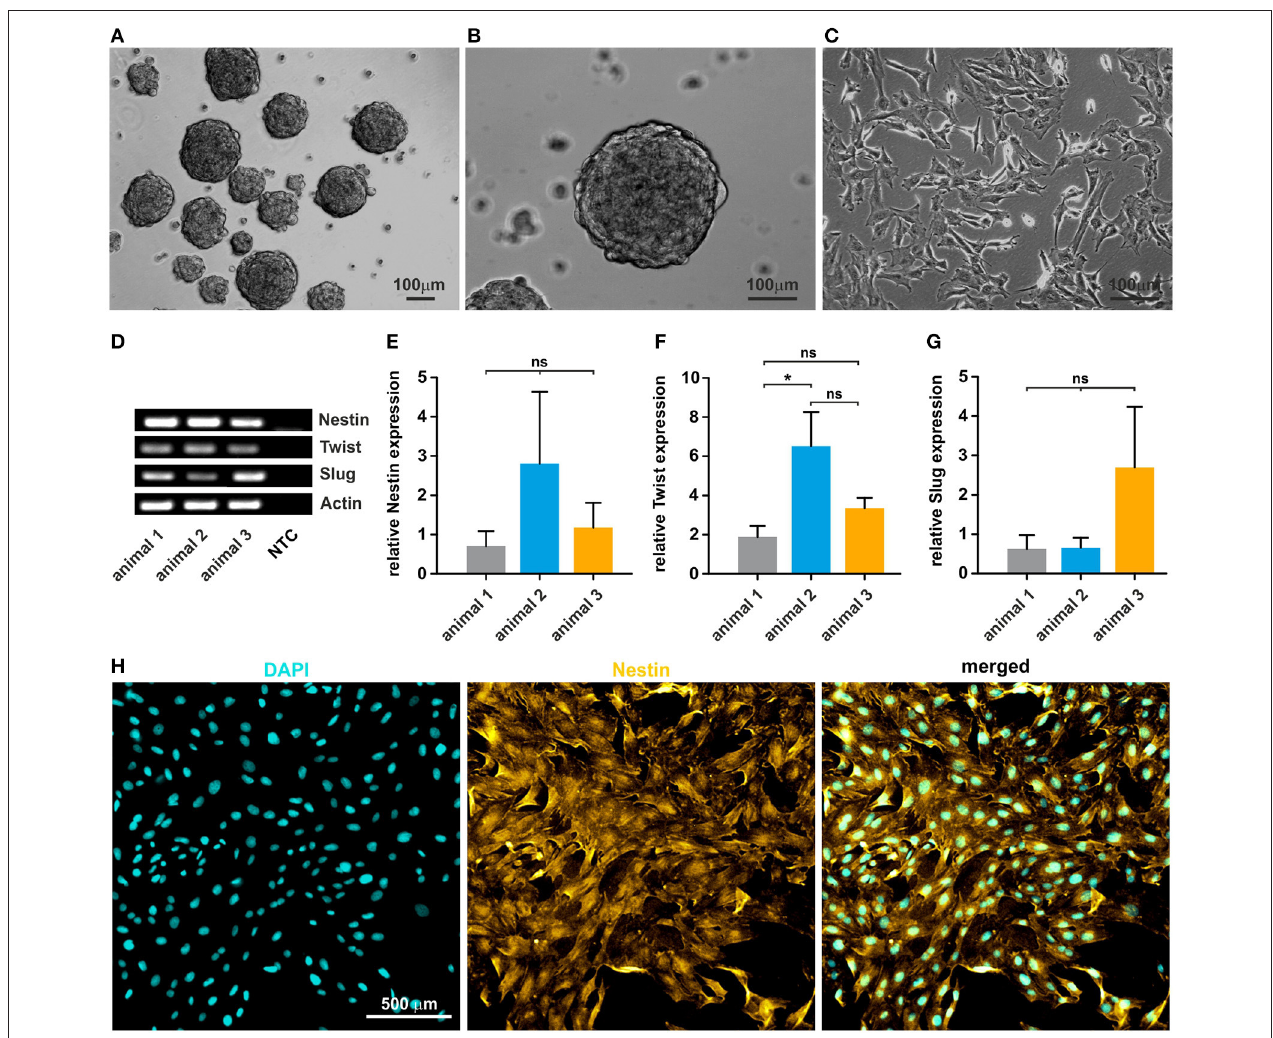
FIGURE 2 | Isolated oNCSCs form neurospheres and show stem cell characteristics in vitro . (A,B) Cells isolated from the ovine sub-palatal tissue form neurospheres in serum-free culture conditions. Scale bar: 100 µ m. (C) Dissociated oNCSCs can be expanded in vitro as adherent monolayer cultures. Scale bar: 100 µ m. (D) oNCSCs express mRNA for the typical neural-crest markers Nestin, Twist, and Slug. NTC: no template control. Actin: housekeeping gene. (E) oNCSCs isolated from different animals express similar levels of Nestin, (F) Twist and (G) Slug. Data is shown as mean ± SEM from three independent experiments, ANOVA with Bonferroni correction, * p < 0.5 was considered significant, CI 95%. (H) Immunocytochemistry revealed expression of Nestin (yellow) at protein level. A representative experiment is shown. Nuclear counterstaining was performed using DAPI (cyan). Scale bar: 50 µ